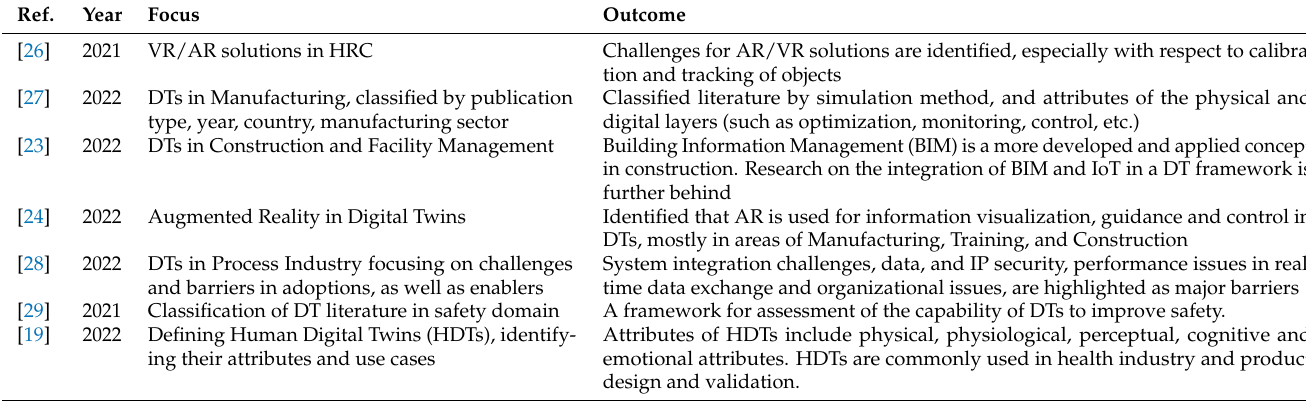
Table 3. Summary of previously published Review Papers on Digital